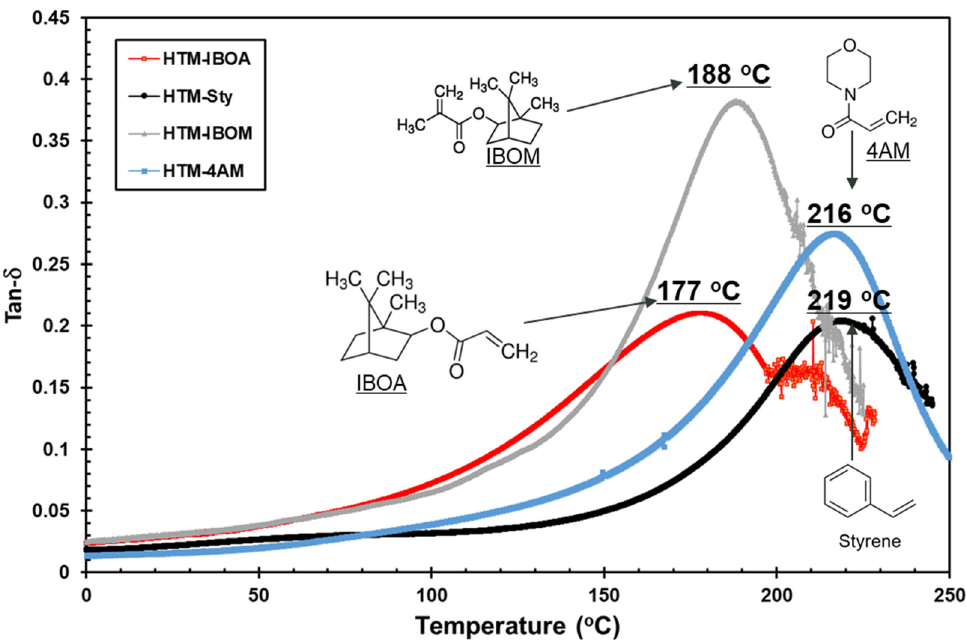
Figure 5. Tan- δ of HTM:diluent photocured thermosets from DMA. Thermosets feature HTM:diluents in a 1:1 mass ratio.